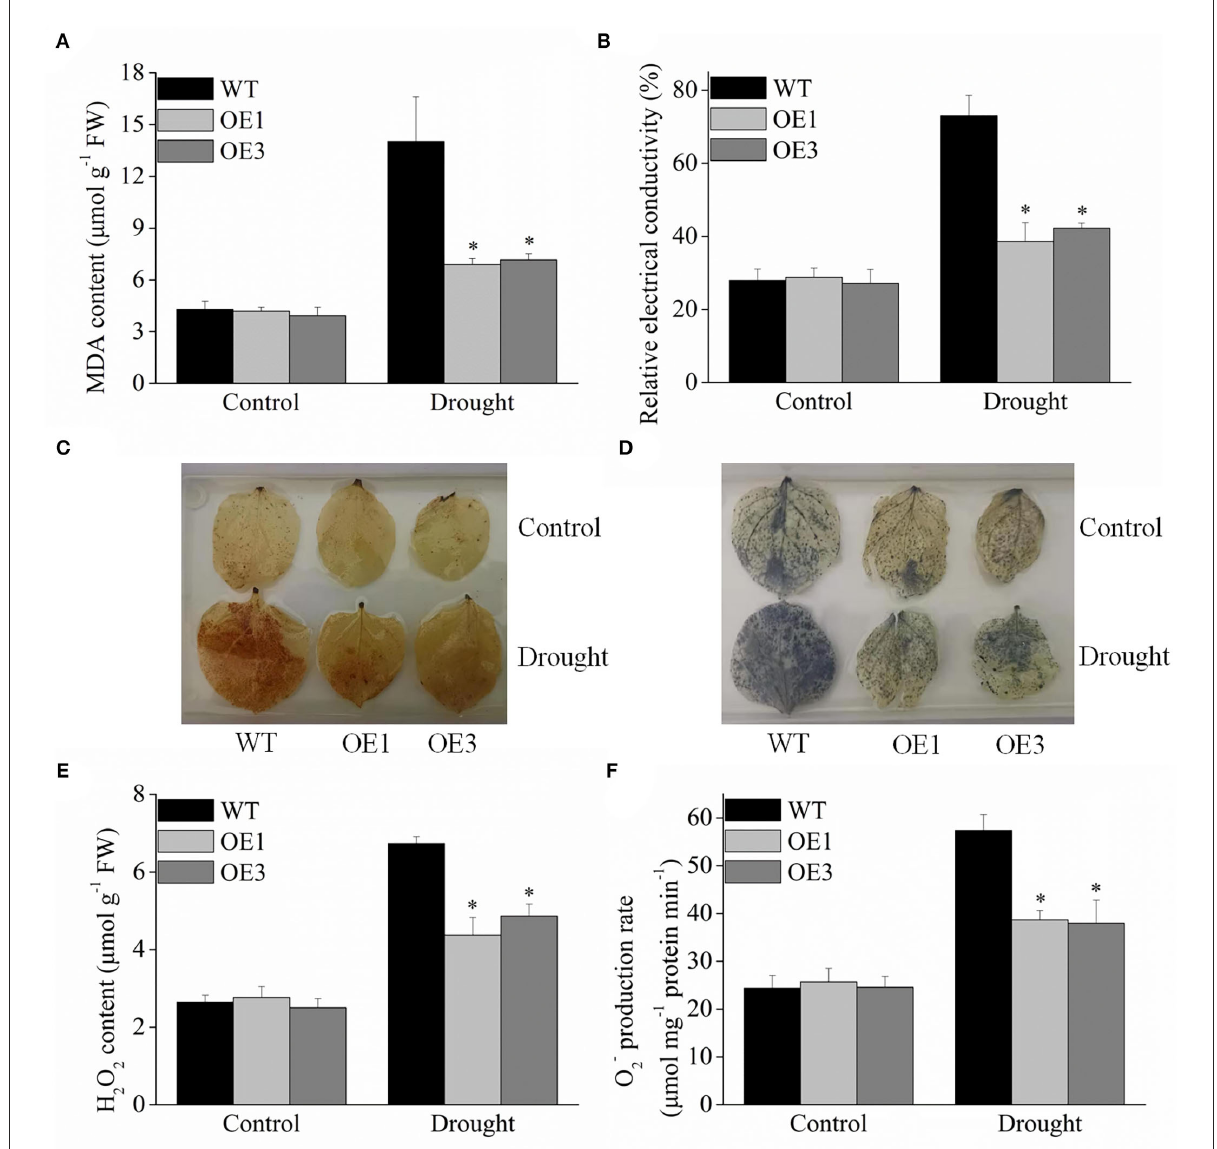
FIGURE7 Oxidation conditions in VyMYB24 transgenic and wild-type plants exposed to drought stress. Four-week-old tobacco plants were treated with drought stress for 10 days, and the MDA content (A) and relative electrical conductivity (B) were checked. (C) , (D) Detection of H 2 O 2 and O − 2 by DAB staining and NBT staining in transgenic and wild-type plants. H 2 O 2 content (E) and O − 2 production rate (F) were evaluated. Bars represent mean ± SD. A significant difference from the WT was confirmed by a one-way ANOVA test, * p <